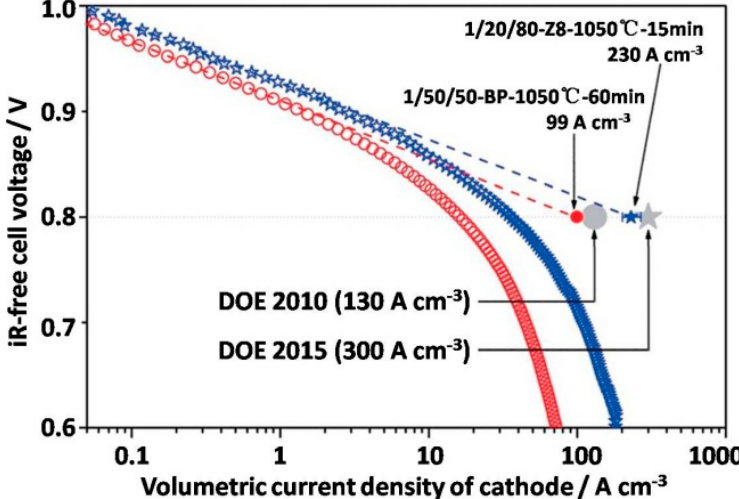
Figure 1. Volumetric current density of the best non-Pt catalysts in H 2 /air fuel cell tests at 80 °C and 100% relative humidity for cathodes [71,72] and the U.S. DOE volumetric activity target at 0.8 V ( iR -free). Red circles: most active iron-based catalyst from previous studies, dashed red line: extrapolation of the linear range to 0.8 V, blue stars: most active iron-based catalyst from the present study, dashed blue line: extrapolation of the linear range to 0.8 V. (Reproduce with permission from Ref. [72]. Copyright © Nature Publishing Group, London, UK,